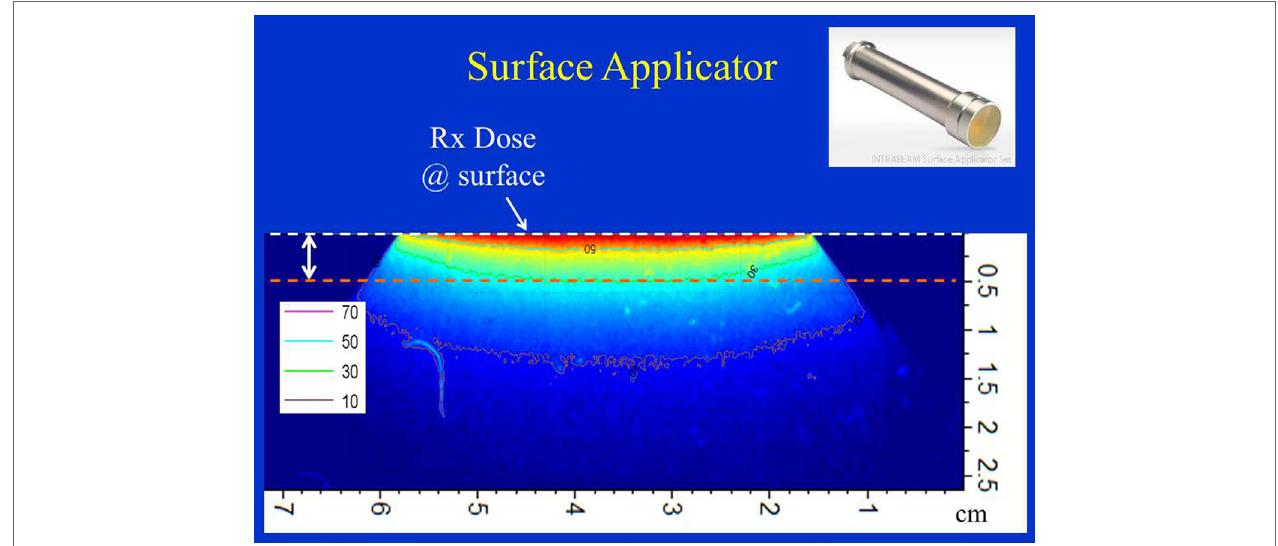
FigUre 9 | Dose distribution from a 4 cm surface applicator. Dose is prescribed at the surface of the phantom. Also indicated is 5 mm superficial layer used to evaluate dose homogeneity. Applicator shown in